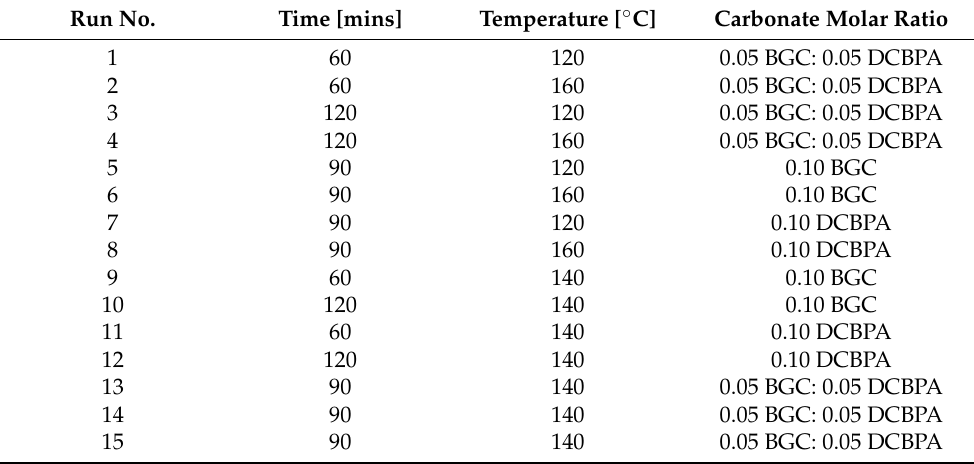
Table 3. Experimental design matrix with actual levels of the factors applied in the experiments. Run